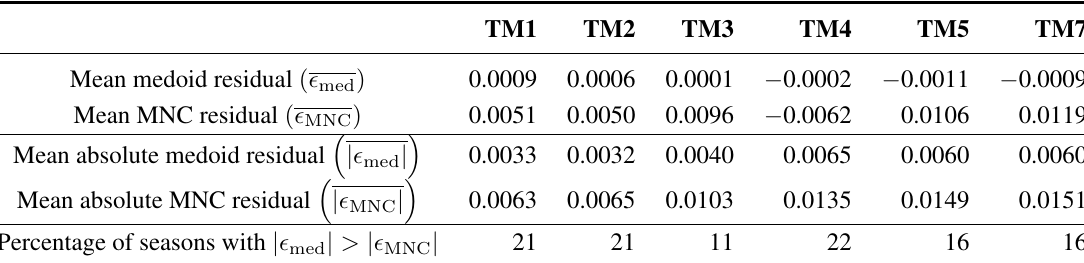
Table 2. Average values of residuals for medoid and MNC seasonal reflectance values, averaged over all pixels in WRS-2 path/row 093/077, for all Landsat TM/ETM+ reflective bands. First two rows compare mean residuals. Next two rows compare mean absolute residuals. The first four rows are all in reflectance units. Final row shows the percentage of seasons of the period March 2000 to November 2012 in which the medoid residual is larger (in absolute value) than the MNC residual.